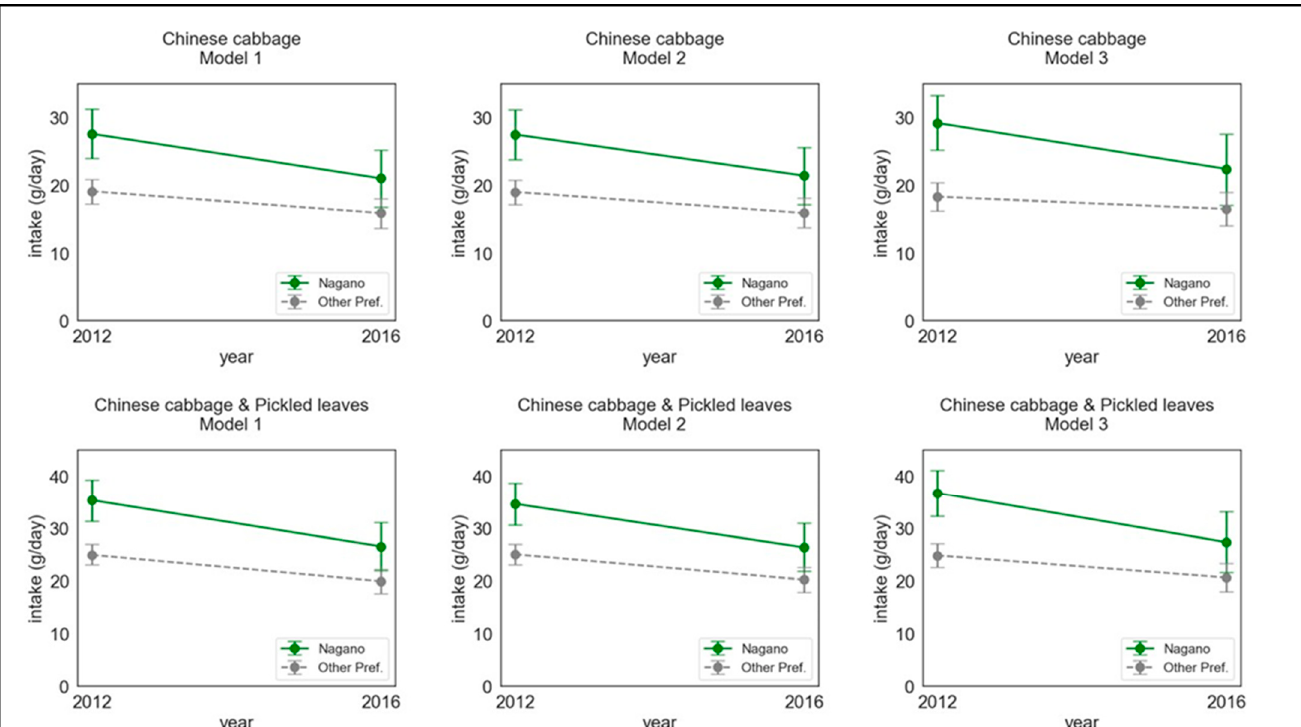
Figure 2. Trends of Chinese cabbage intake according to prefectures. Nagano: only Nagano Prefecture; Other pref.: prefectures among Kanto 2 other than Nagano (i.e., Ibaraki, Tochigi, Gunma, and Yamanashi). Details of the data are shown in Table A3.